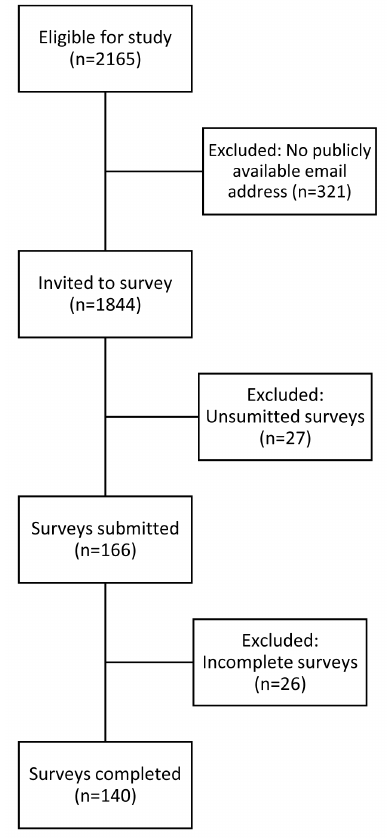
Figure 1. Diagram of study